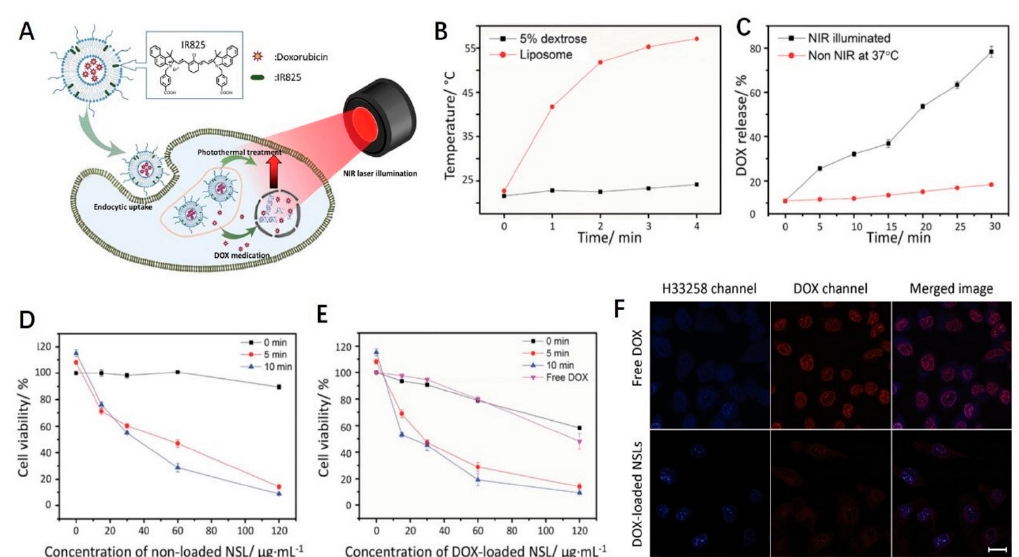
Figure 5. IR825 dye as a photothermal conversion agent. ( A ) Schematic illustration showing the structure and action mechanism of NIR-absorptive DOX-loaded stealth liposome; ( B ) heating curves of the hydration solution (5% dextrose) and the NSL solution upon continuous NIR laser illumination at a laser power density of 0.5 W·cm − 2 ; ( C ) DOX release profiles of DOX-loaded NSL at physiological temperature and under NIR light irradiation (power density: 0.5 W·cm − 2 ), respectively. Relative viabilities of HeLa cells incubated with ( D ) nonloaded NSL and ( E ) DOX-loaded NSL at various concentrations without and with NIR laser illumination for 5 and 10 min, respectively; ( F ) confocal laser fluorescence spectroscopy images of live HeLa cells incubated with free DOX (3 μ g·mL − 1 ) or DOX-loaded NSL (200 μ g·mL − 1 ) solutions. The cell nuclei were stained with H33258. Scale bar is 10 μ m. Reproduced with permission from ref. [106] Copyright (2015). Wiley-VCH Verlag.